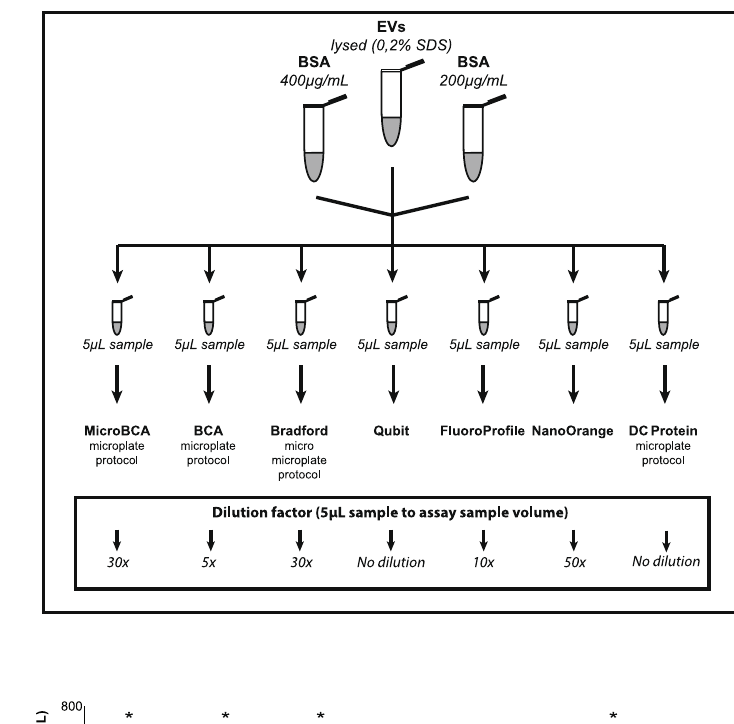
8 Scientific RepoRts | 7: 2704 | DOI:10.1038/s41598-017-02599-y